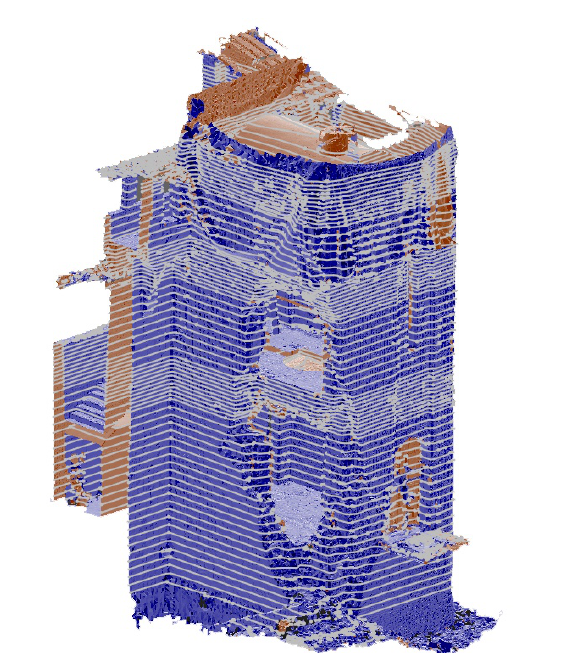
Figure 7. Mesh with slices at variable distance